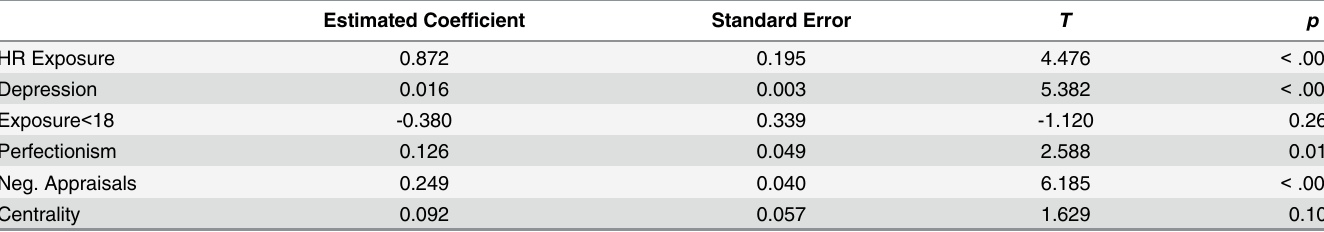
Table 6. Multiple linear regression analysis predicting